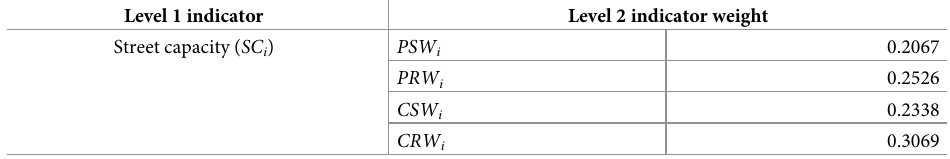
Table 1. The weight measurement of 4 indicators for evaluating the street